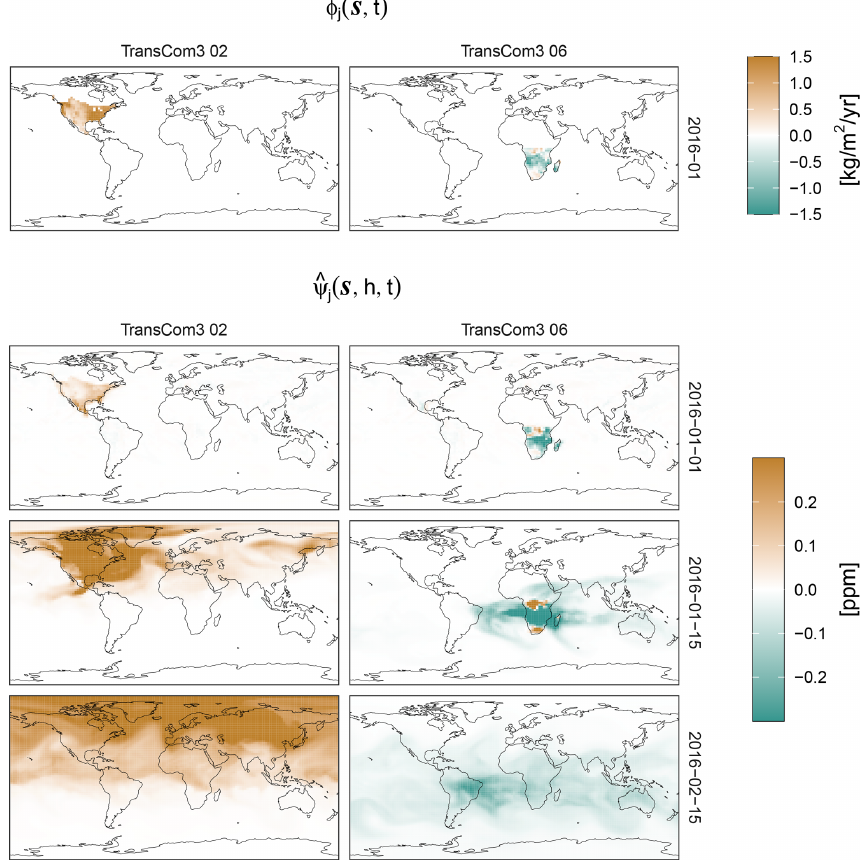
Figure 2. Examples of flux basis functions that have support in the month of January 2016 in the regions TransCom3 02 and TransCom3 06 and the corresponding mole-fraction basis functions. The first row shows the values of the flux basis functions, φ j ( · , · ) , averaged over the whole month (these basis functions are zero outside January 2016). The next three rows show daily averages of the column-averaged CO 2 for the corresponding mole-fraction basis functions on 3 different days: the start of the month-long period where the flux is non-zero, 1 January 2016; the middle of the period, 15 January 2016; and 15d after the end of the period, 15 February